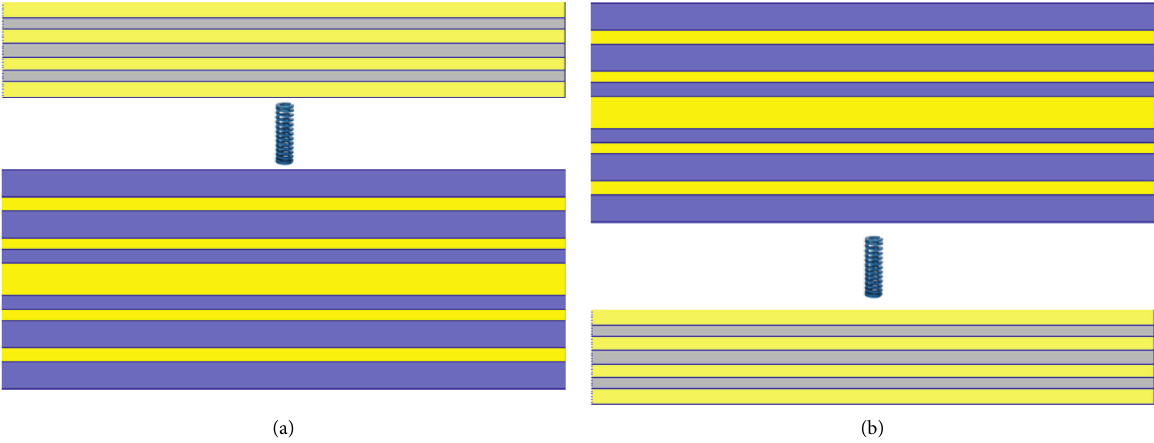
Figure 20: Schematic diagram of the model movement. (a) Upward movement of the interference layer. (b) Downward movement of the interference layer.